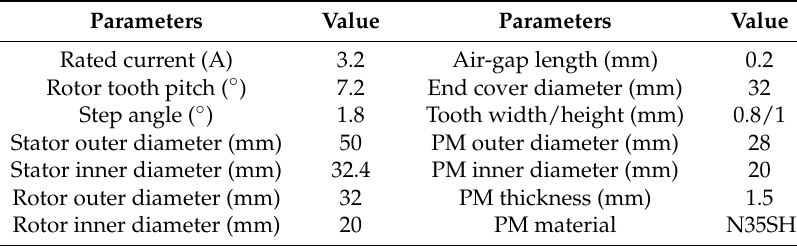
Table 2. The different parameters of sub-motor1 and sub-motor2.